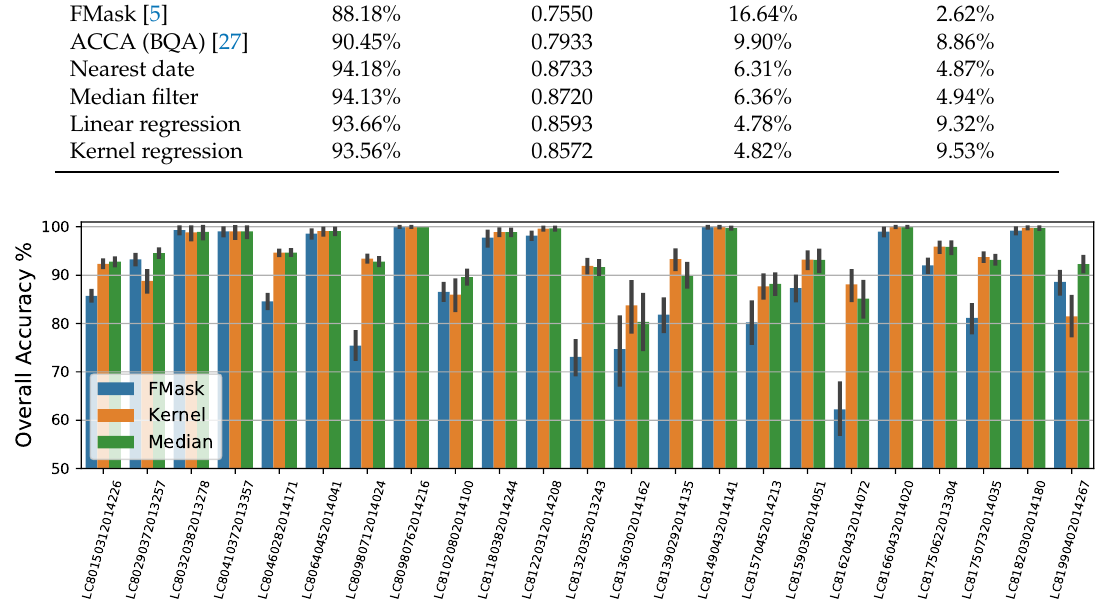
Figure 7. Average accuracy over the image patches for each of the 23 different Landsat-8 acquisitions selected from the Biome